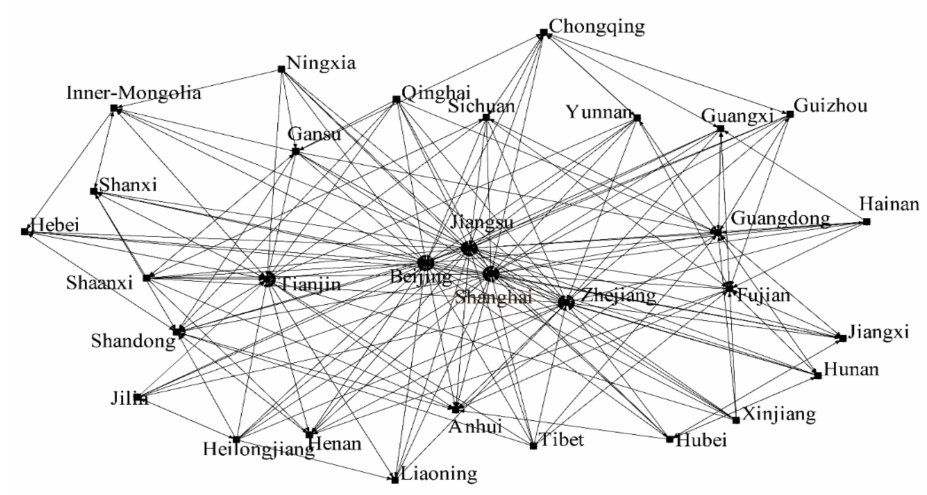
Figure 2. China’s agricultural science and technology resource allocation efficiency spatial relation network.